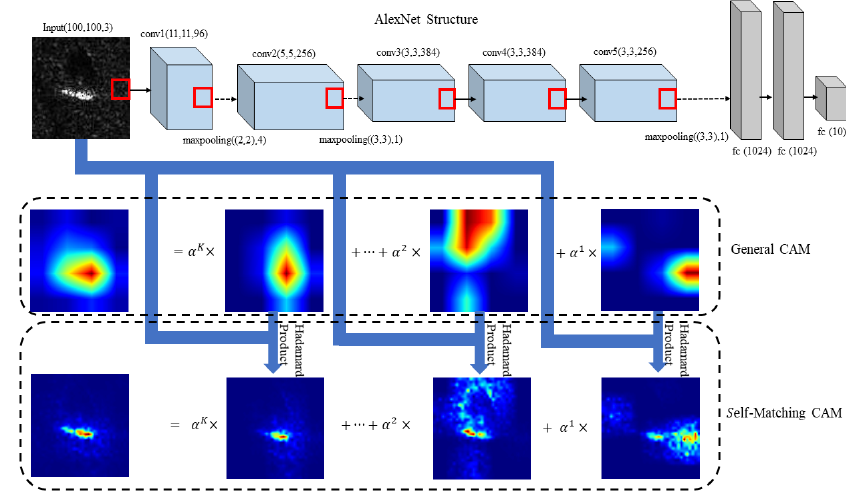
Figure 2. Flowchart of Self-Matching CAM. Here the AlexNet model is taken as an example. Algorithm 1 Self-Matching